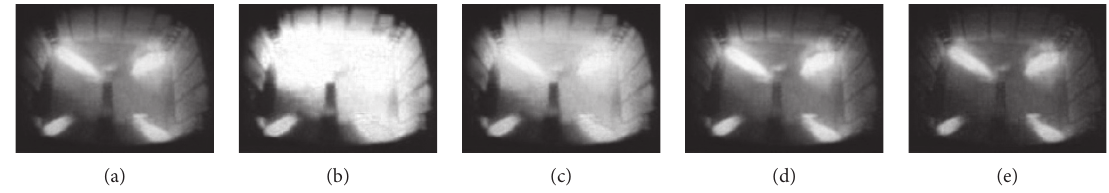
Figure 4: The comparison results of flame image III under different methods: (a) average method; (b) maximum method; (c) weighted average method 1; (d) weighted average method 2; (e) weighted average method 3.